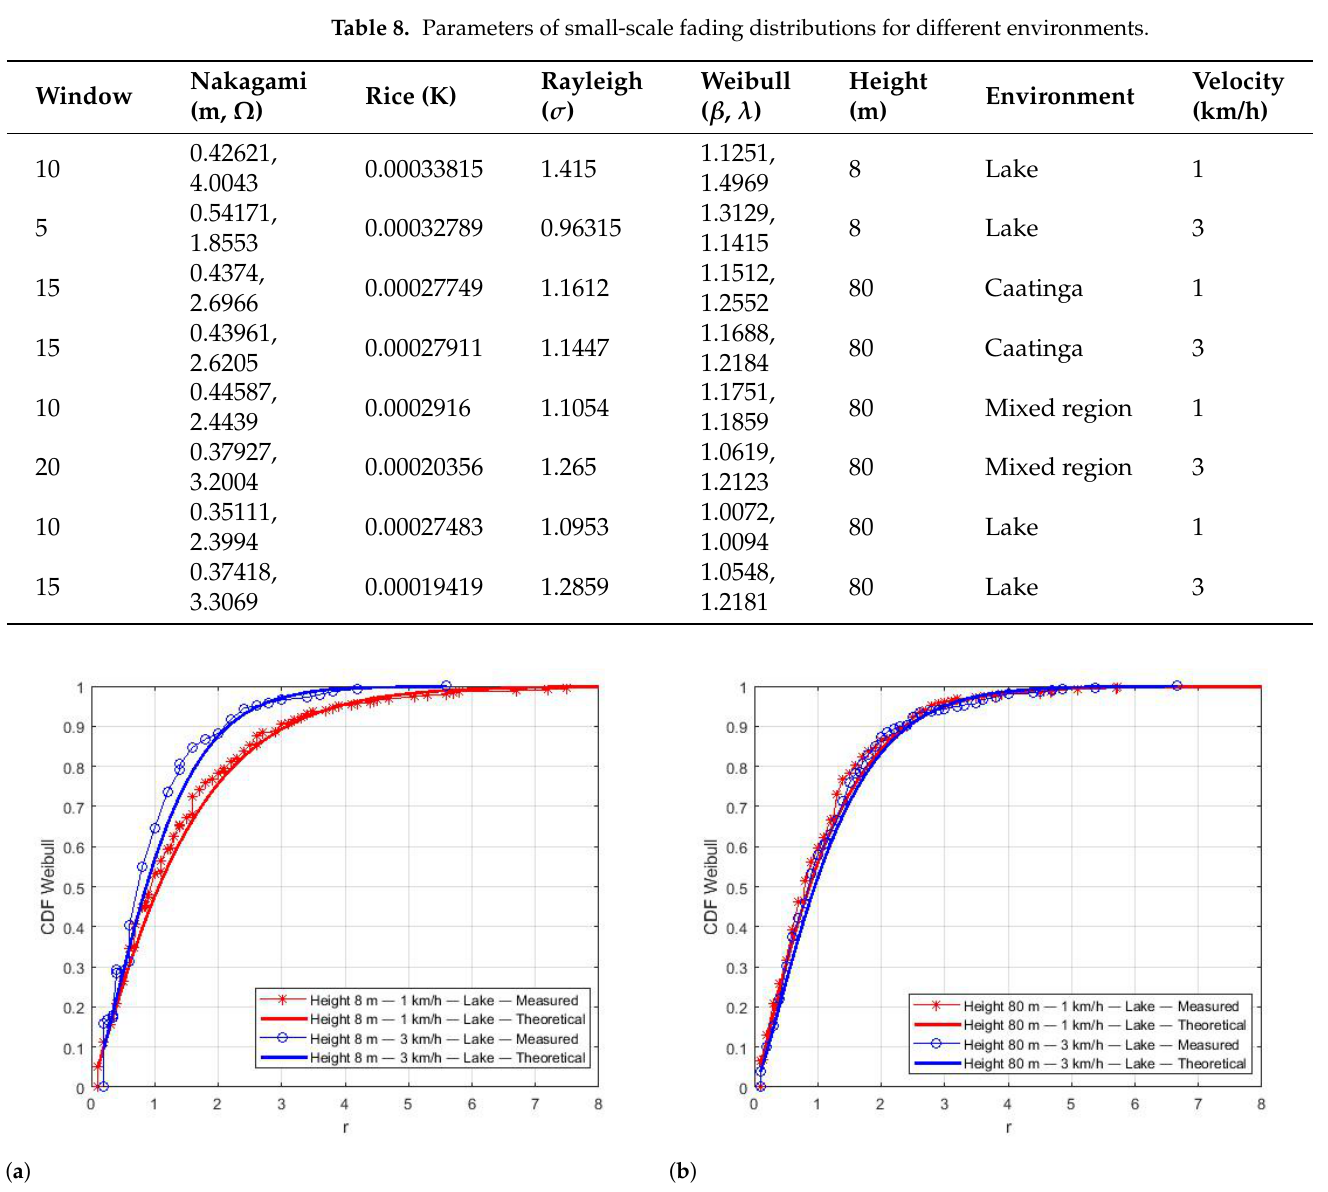
Figure 9. Estimated CDFs over the lake for the same height. ( a ) CDFs over the lake at 8 m. ( b ) CDFs over the lake at 80